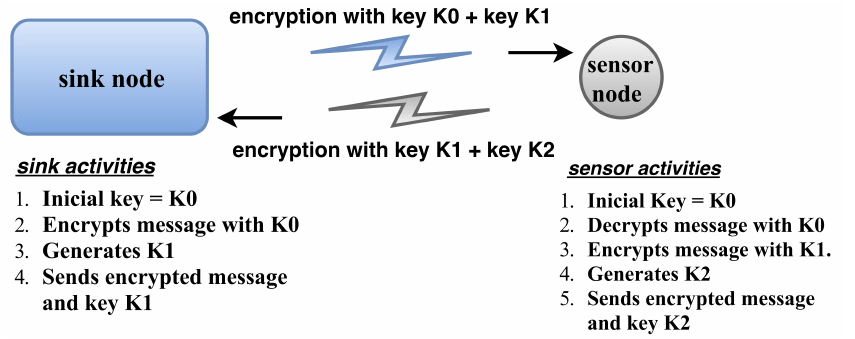
Figure 3. Encryption technique and activities in the sink and sensor